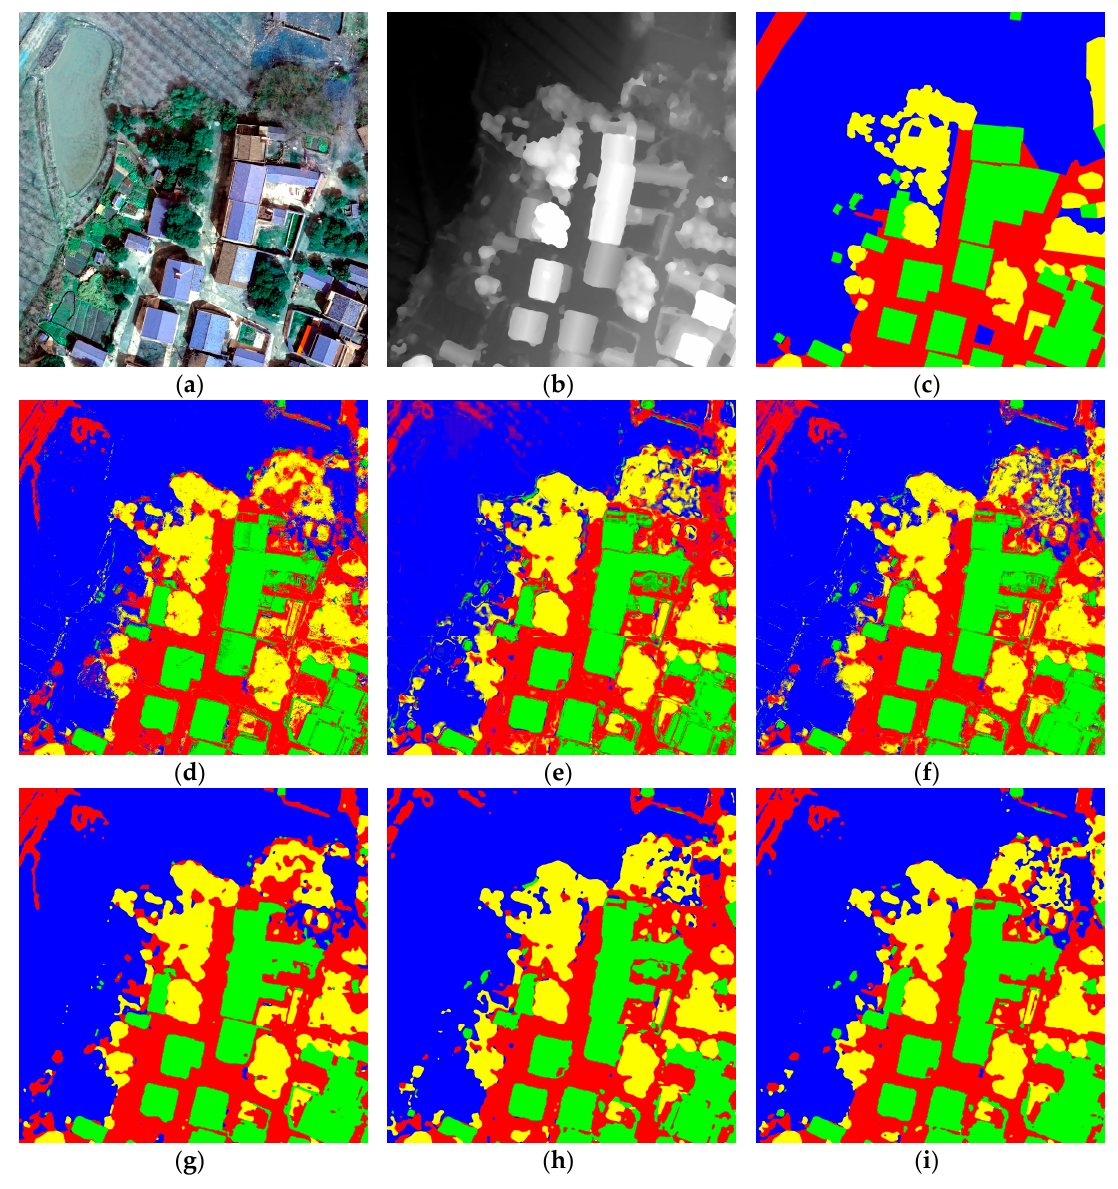
Figure 4. Classification results of LULC classification dataset in rural areas of Wuhan city. ( a ) remote sensing image; ( b ) NDSM; ( c ) ground truth; ( d ) SD-SVM classification; ( e ) FCNN-SVM classification; ( f ) CMP -SVM classification; ( g ) SD-FCCRF classification; ( h ) FCNN-FCCRF classification; ( i ) CMP-FCCRF classification (C1 Red: impervious surfaces; C2 Green: homestead; C3 Blue: background; C4 Yellow: trees).